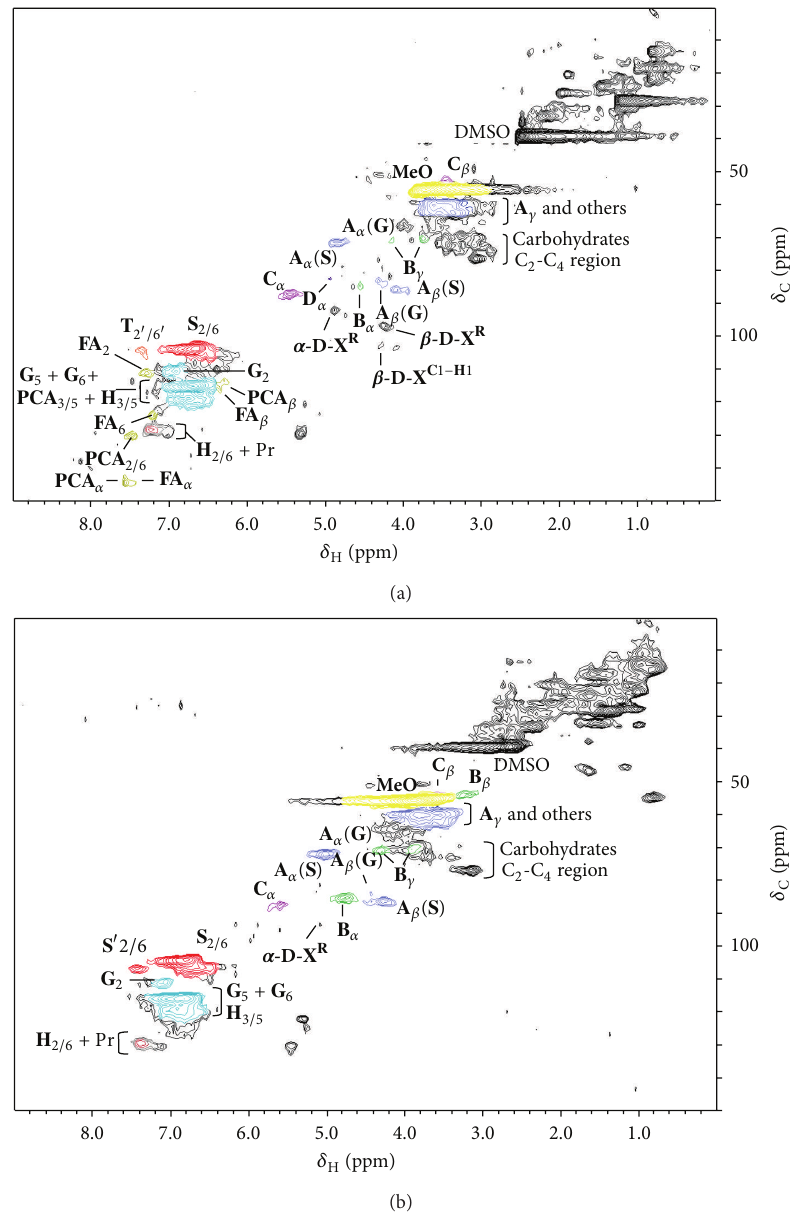
/𝛿 Figure 2: HSQC 2D-NMR spectra, 𝛿 0–150/0–9 ppm region, of the lignin-rich residues from wheat straw (a) and olive tree pruning (b) C H WIS fractions. The aliphatic, oxygenated aliphatic, and aromatic region are observed. Cross signals of the residual DMSO and protein residue (Pr) are